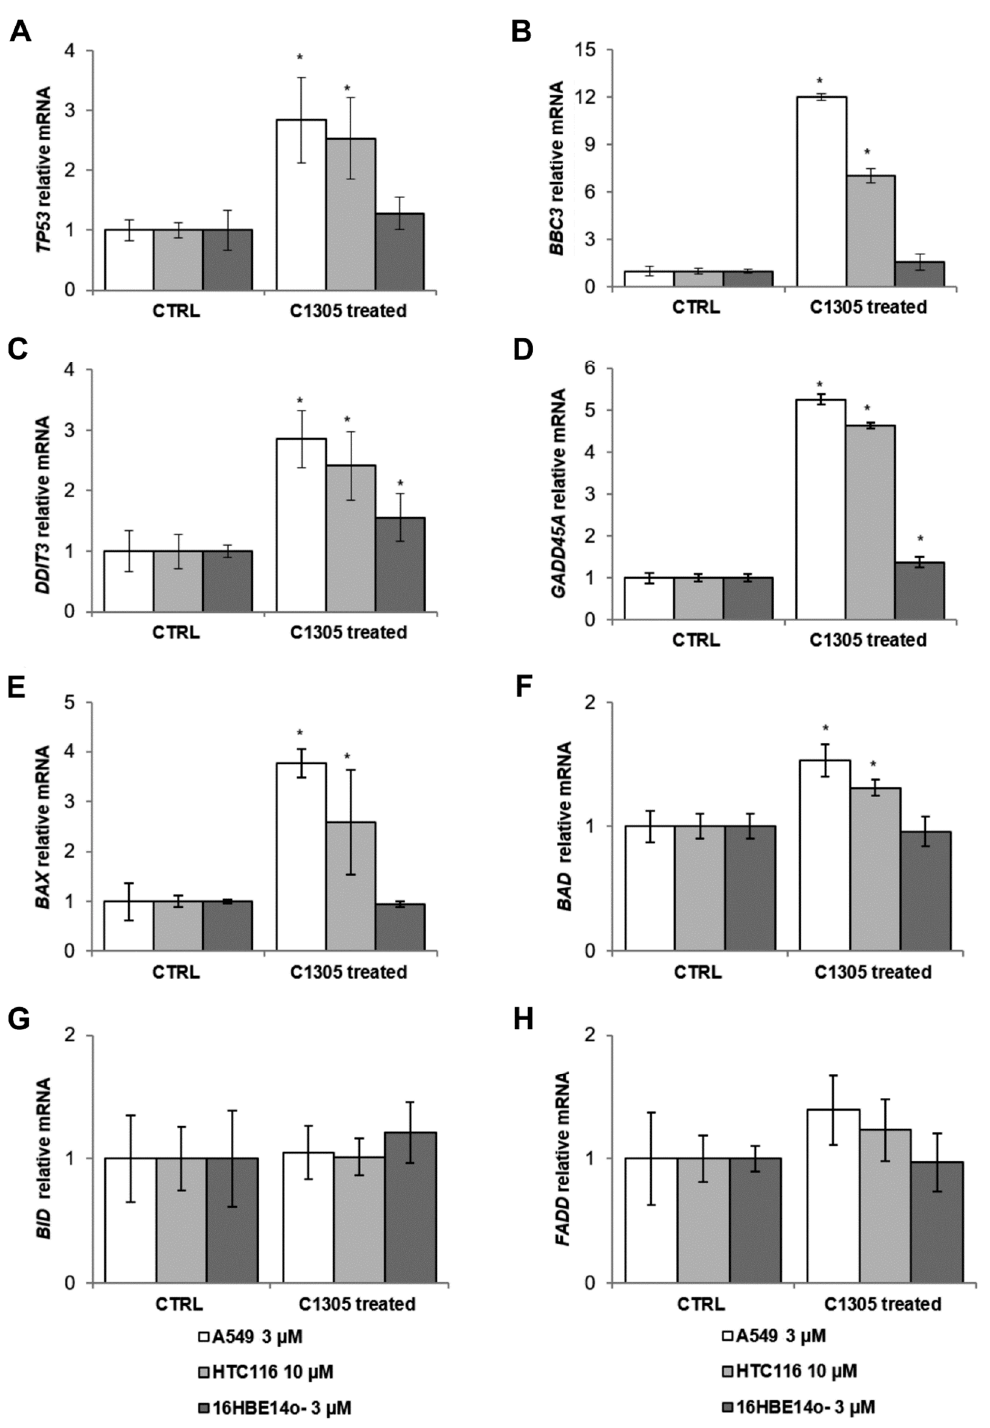
Figure 3. Exposure of A549 and HTC 116 cells to C-1305 activates transcriptional apoptotic signaling. A549 and 16HBE14o- cells were exposed to 3 µM C-1305 for 24 h, whereas HTC 116 cells were exposed to 10 µM C-1305 for 24h and levels of ( A ) TP53, ( B ) BBC3, ( C ) DDIT3, ( D ) GADD45A ( E ) BAX, ( F ) BAD, ( G ) BID, and ( H ) FADD were measured with qPCR. The results from three independent experiments ( n = 6) are plotted normalized to TBP mRNA levels and expressed as a fold-change over the DMSO vehicle controls. Error bars represent standard deviations. Significant changes ( p < 0.05) are marked with an asterisk.